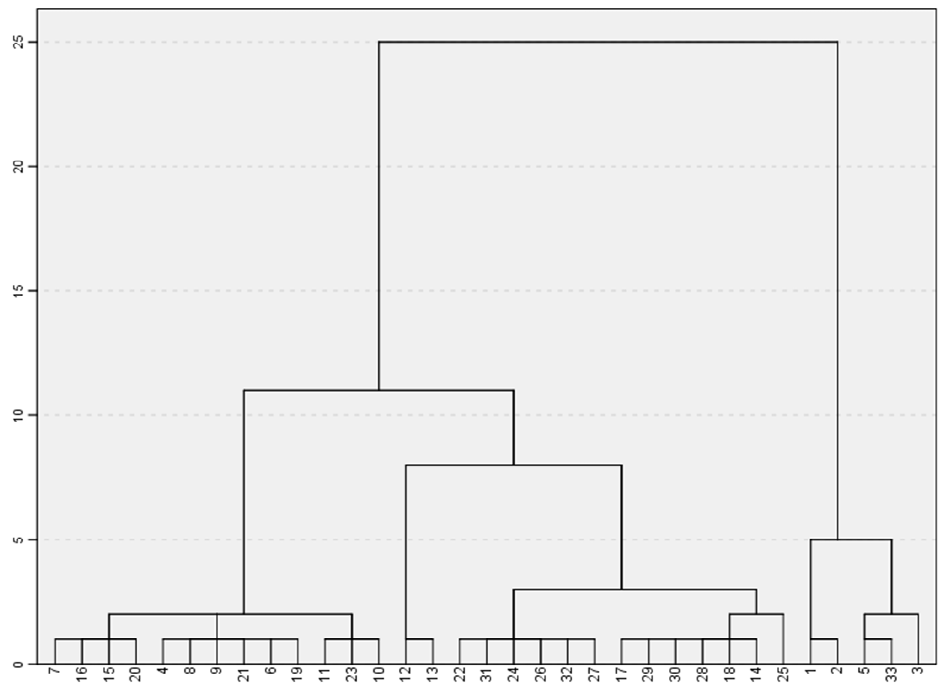
Figure 3. Cluster analysis of paper mulberry from different provenances.